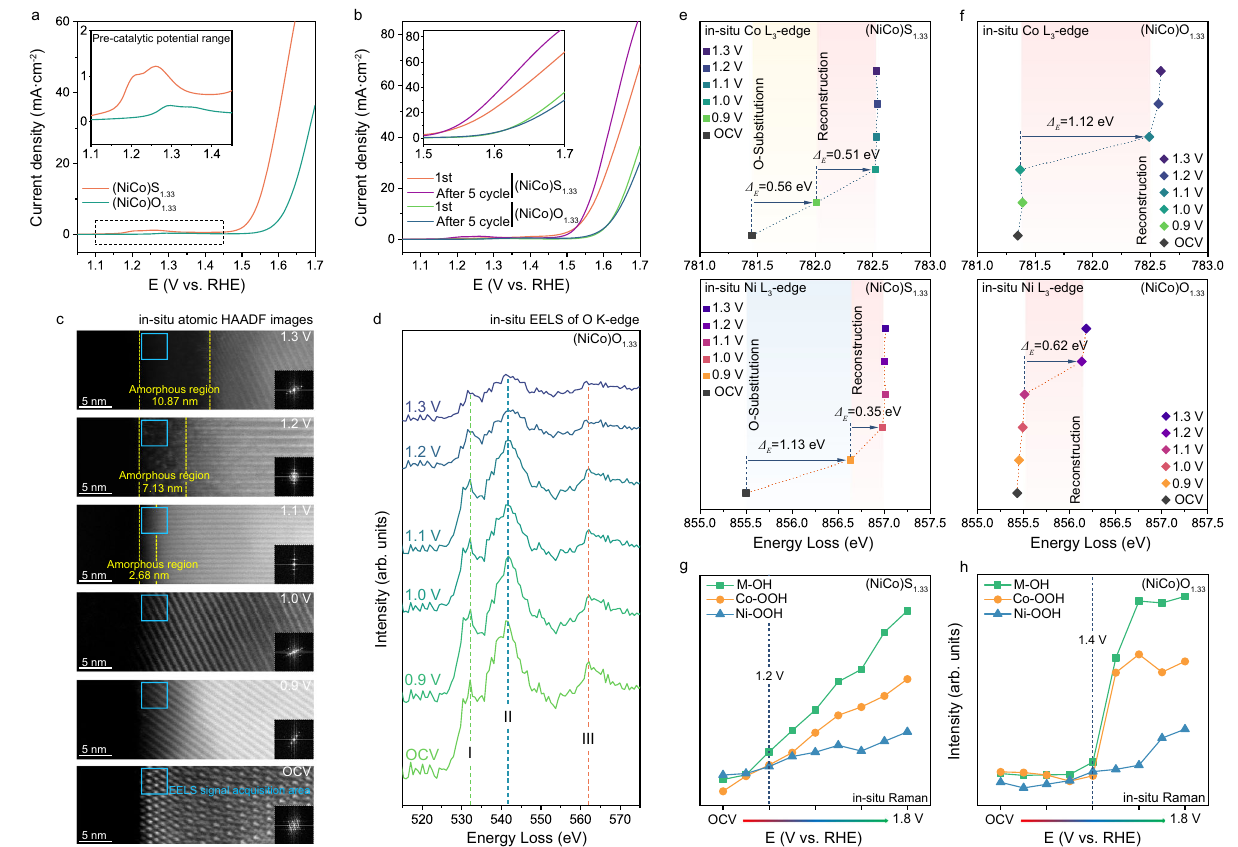
Fig. 6 | Comparison of the (NiCo)O x S 1.33-x surface and the pure (NiCo)O 1.33 surface. a iR-corrected LSV at a scan rate of 5mVs − 1 of (NiCo)S 1.33 and (NiCo)O 1.33 . b iR-correctedLSVof(NiCo)S 1.33 and(NiCo)O 1.33 beforeandafter fi veCVcyclesata scan rate of 5mVs − 1 . c In-situ atomic HAADF images of (NiCo)S 1.33 after constantly applyingdifferentpotentialsfortwentyseconds. d In-situEELSspectraofOK-edge